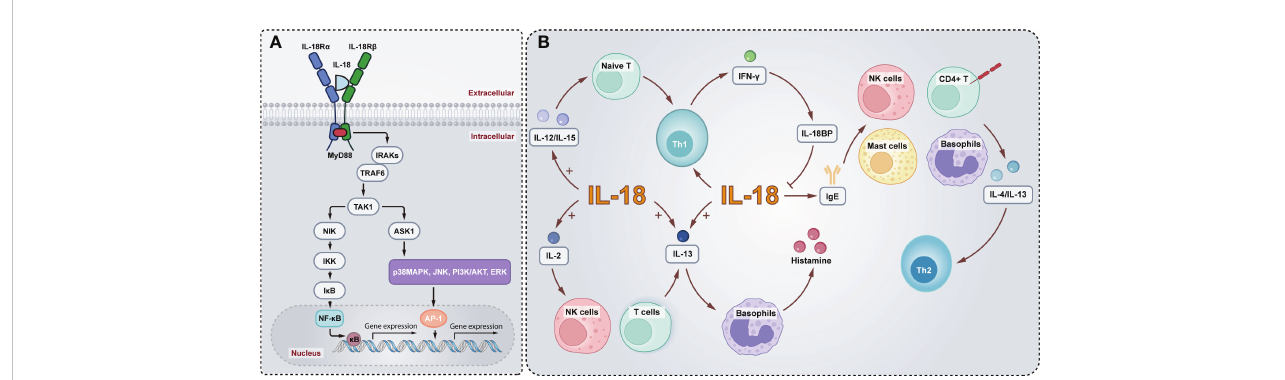
FIGURE 2 Schematic model of the IL-18 signaling pathways and biological functions. (A) Active IL-18 is secreted extracellular, and activation of IL-18R recruits MyD88 into the TIR domain and anchors IRAKs, which bind to TRAF6 associating with TAK1. TAK1 in turn phosphorylates NIK. This is followed by the activation of IKK, phosphorylation of I k B, and fi nally nuclear translocation of NF- k B, which regulates the transcription of in fl ammatory genes. In addition, the TRAF6 activates ASK1 through TAK1, and contributes to activate p38MAPK, JNK, PI3K/AKT and ERK, leading to the activation of AP-1. (B) IL-18 enhances Th1 production of IFN- g which in turn induces IL-18BP inhibits IL-18. Mature IL-18 with IL-12 or IL-15 induces differentiation of naive T cells into Th1 cells. Alternatively, IL-18 alone elevates IgE and actives mast cells, basophils, NK cells, and CD4 + T cells to produce IL-13 and IL-4, driving a Th2 response. Furthermore, IL-18 and IL-2 promote IL-13 production in NK cells and T cells and, in conjunction with IL-13, induce histamine release from